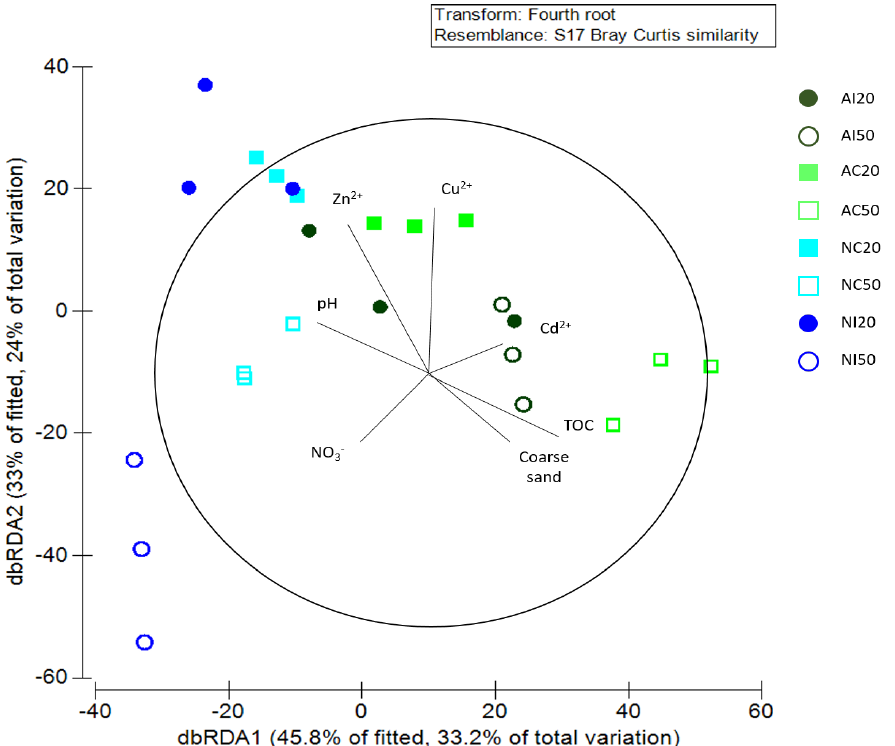
Figure 9. The dbRDA (distance-based redundancy analysis) ordination of rare meiobenthic assem- blages vs. the significant explanatory environmental variables. Vector overlays represent multiple partial correlations of the explanatory variables with the distance-based redundancy analysis (dbRDA) axes. See text for further explanation.